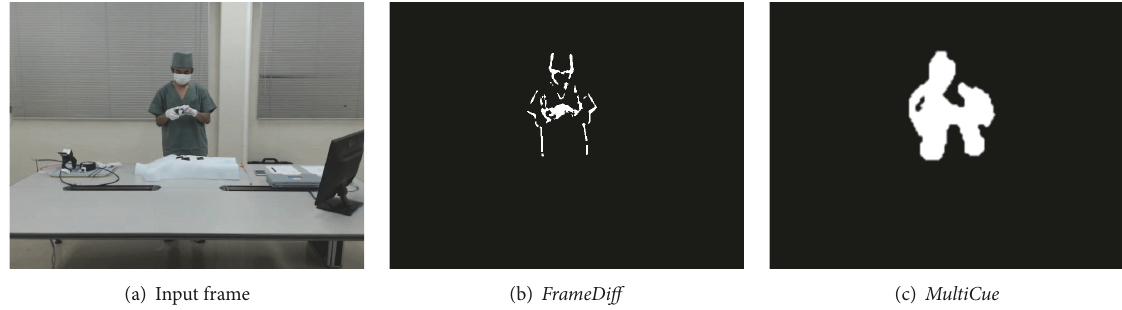
Figure 3: An example of an input frame and corresponding foreground detection results.